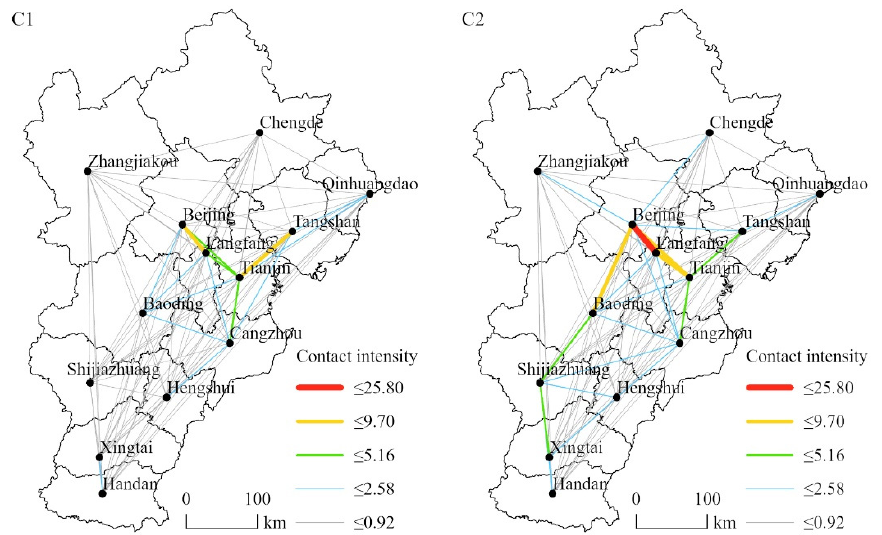
Figure 4. Comparison of population mobility network patterns in C1 and C2.